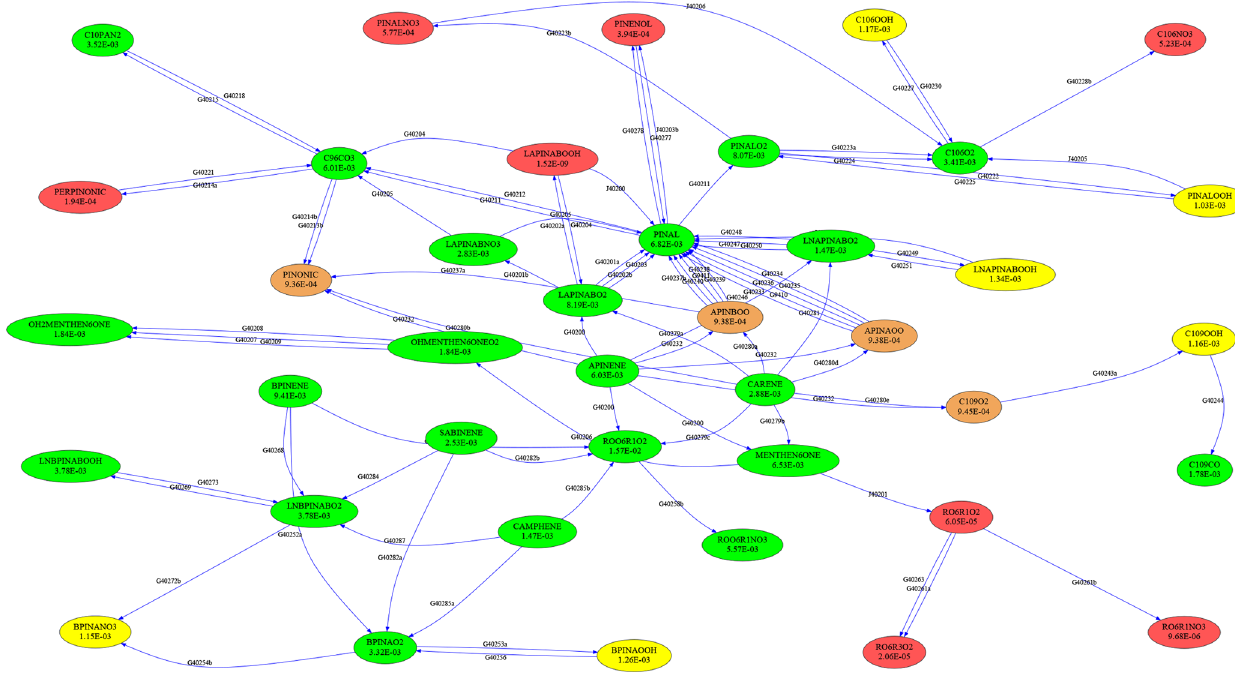
Figure 4. Skeletal reduction of terpene chemistry in the MOM reaction scheme (only C 10 species are shown here). Vertex colors and OIC values correspond to those in Table 3; only the green and yellow species are kept in the reduced